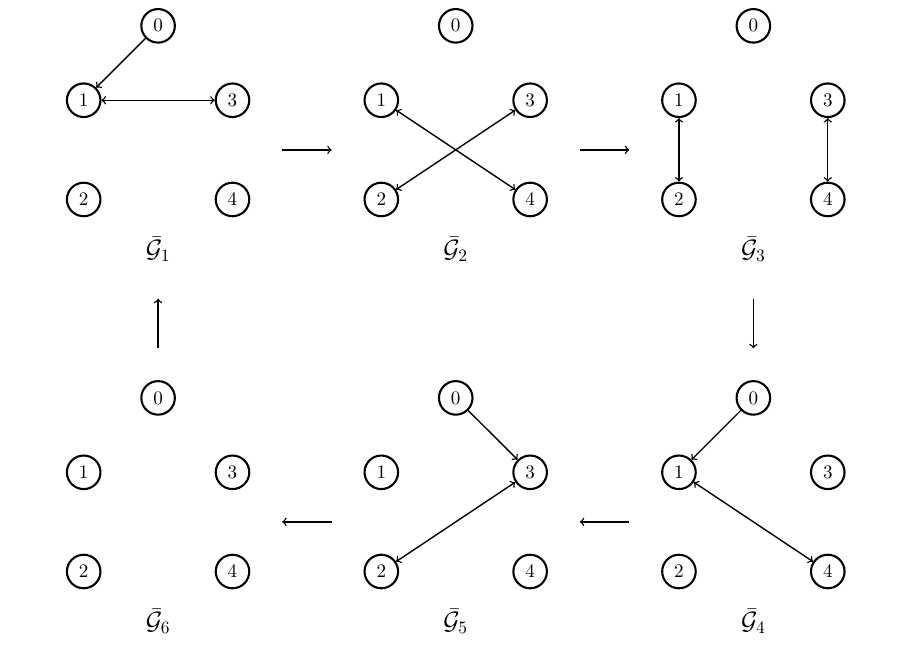
Figure 3. The switching topology of the communication network ¯